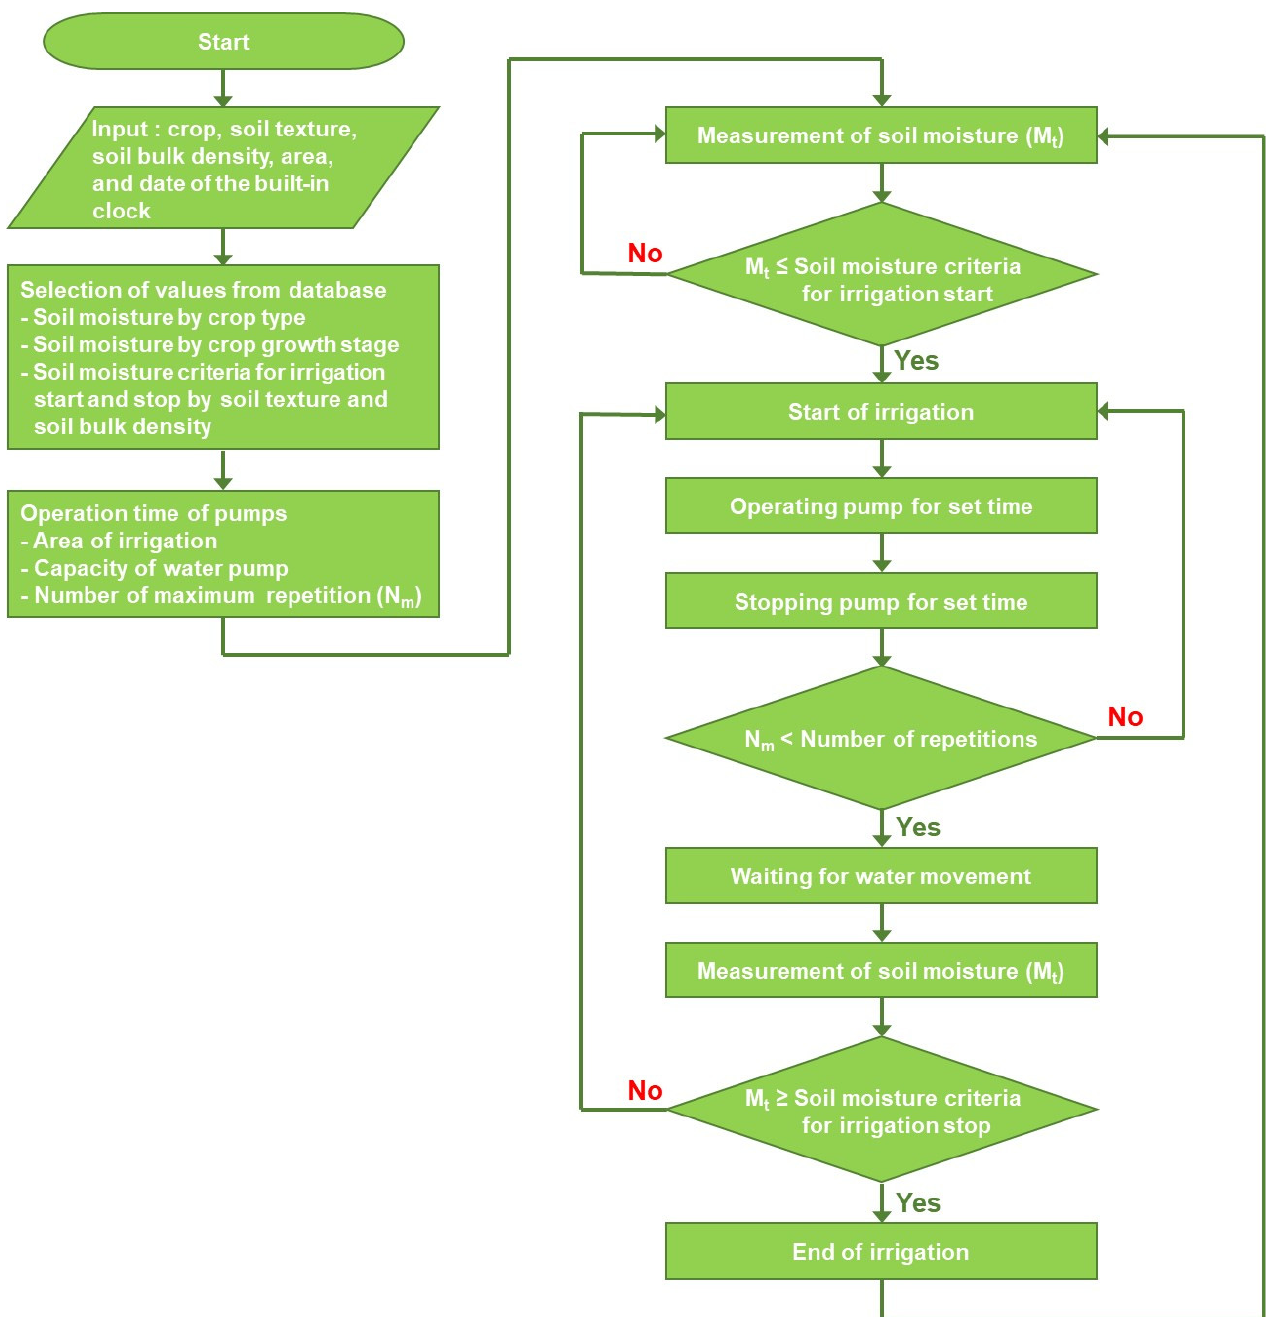
Figure 2. The algorithm for intermittent irrigation.